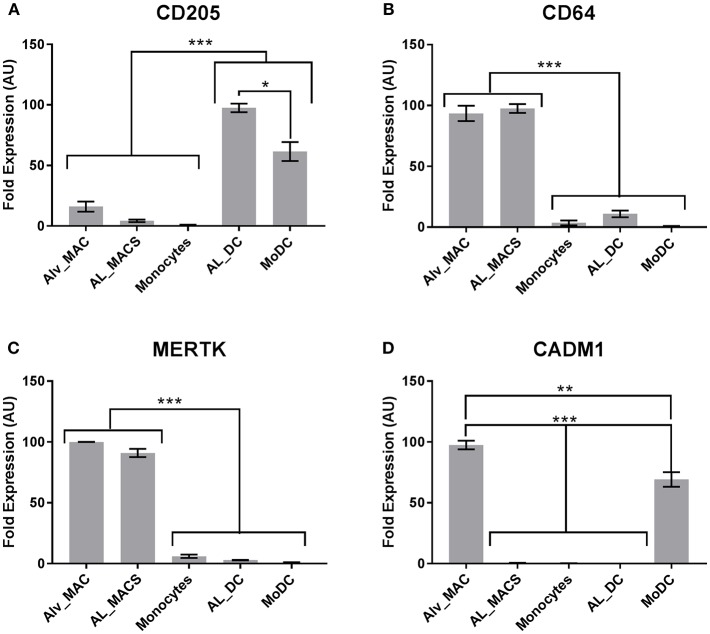
Bovine macrophages and DCs express common signatures with cells from other species. Bovine Macs and DCs (N = 4) were gated as in Figure 1 and sorted by flow cytometry. mRNA expression levels of (A) CD205, (B) CD64, (C) MERTK and (D) CADM1 were assessed by quantitative real-time PCR in triplicate. For each gene, data were normalized to the reference gene (18S rRNA) expression and presented as relative expression [arbitrary units (AUs)]: for each animal, the population with the highest expression for this gene was considered as 100 and the other populations were normalized to it. *p > 0.01, **p > 0.001, and ***p > 0.0001. Error bars indicate standard error of the means (SEM).